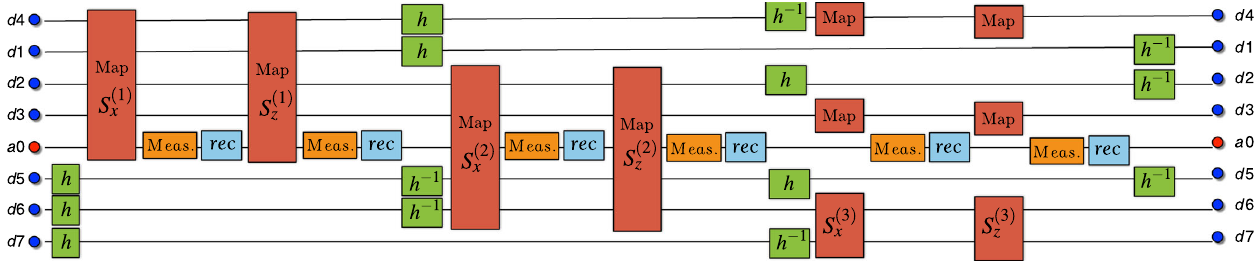
FIG. 20. Circuit representation of the hiding-based, two-species QEC cycle with multiqubit MS gates: We use the same conventions as in Fig. 16. The additional hiding h and unhiding operations h − 1 , represented by green boxes, are realized by composite pulse sequences to coherently map the state of physical qubits from 4 S 1 (see Sec. III C).